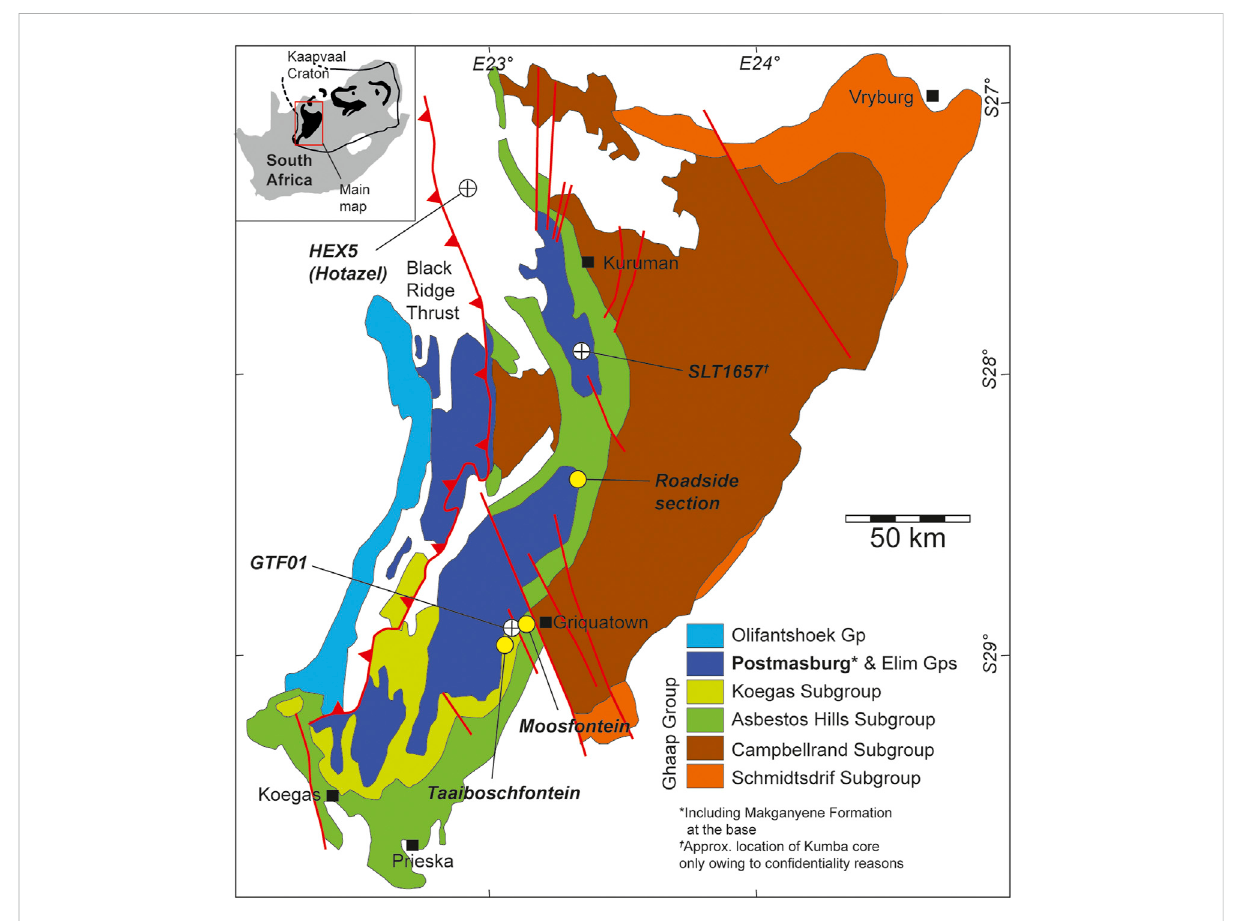
FIGURE 2 Geological sketch map (redrawn after Schröder et al., 2011) including the location of outcrops visited and boreholes examined in this